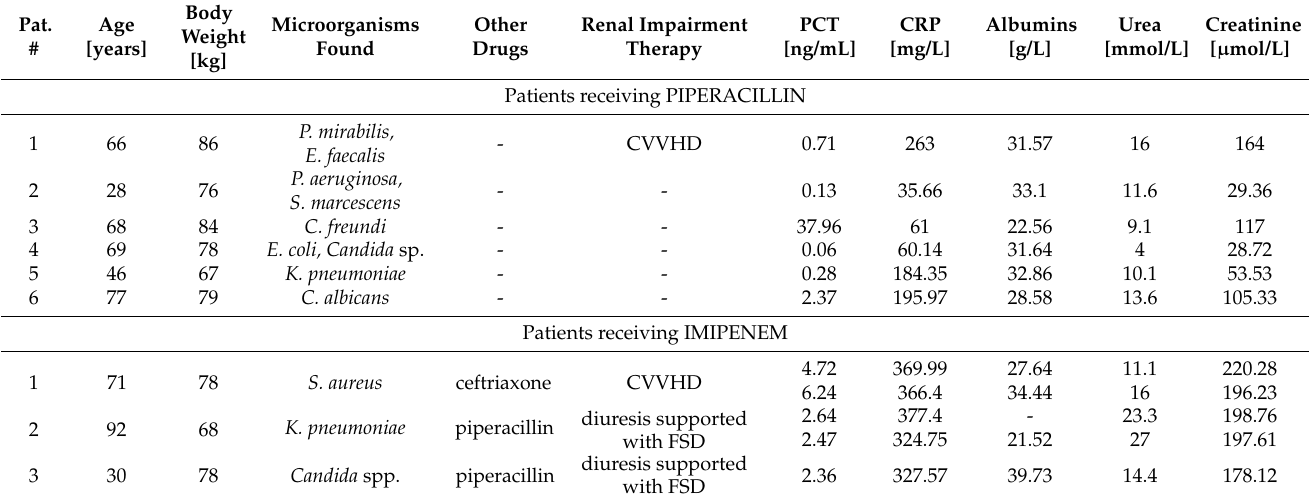
Table 7. Characteristics of VAP patients included in BAL sampling. Other antibiotics are considered only if administrated within one week before sample collection. week before imipenem admin- istration; PCT—procalcitonin reference range: < 0.05 ng/mL; CRP—C-reactive protein reference range: <5 mg/L; Albumins reference range: 32–48 g/L; Urea reference range: 3.2–8.2 mmol/L; Creatinine reference range: 61.9–114.9 µ mol/L; CVVHD—continuous venovenous hemodialysis;